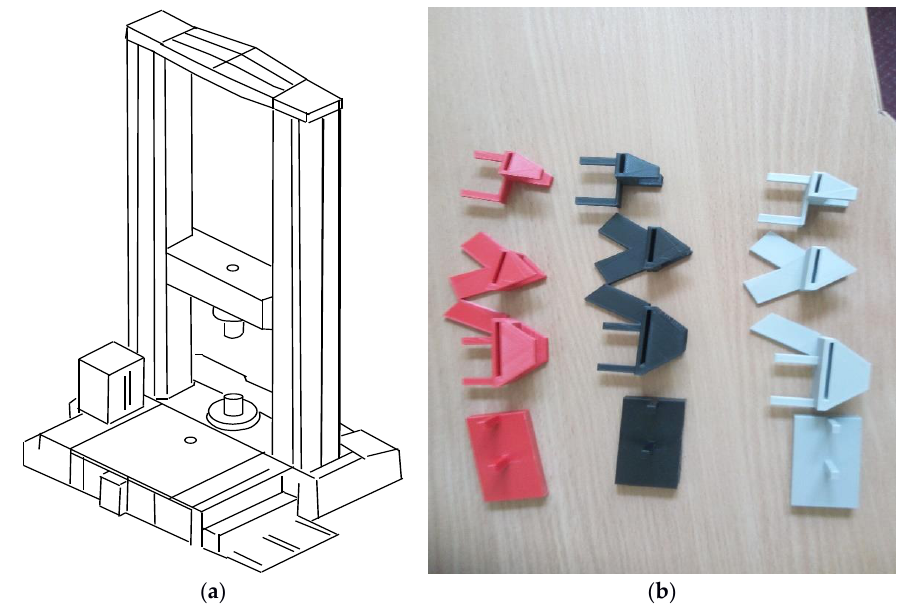
Figure 1. ( a ) INSTRON 5966 and ( b ) test samples of the exoskeleton parts.